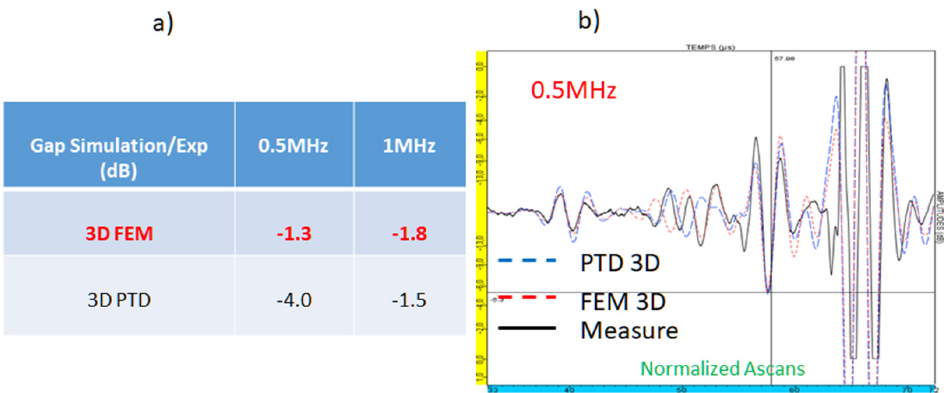
Figure 19. ( a ) Gap between simulation and experience for the 3D hybrid FEM model and for the 3D PTD model; ( b ) Superimposition of the normalized experimental and simulated AScans at 0.5 MHz.